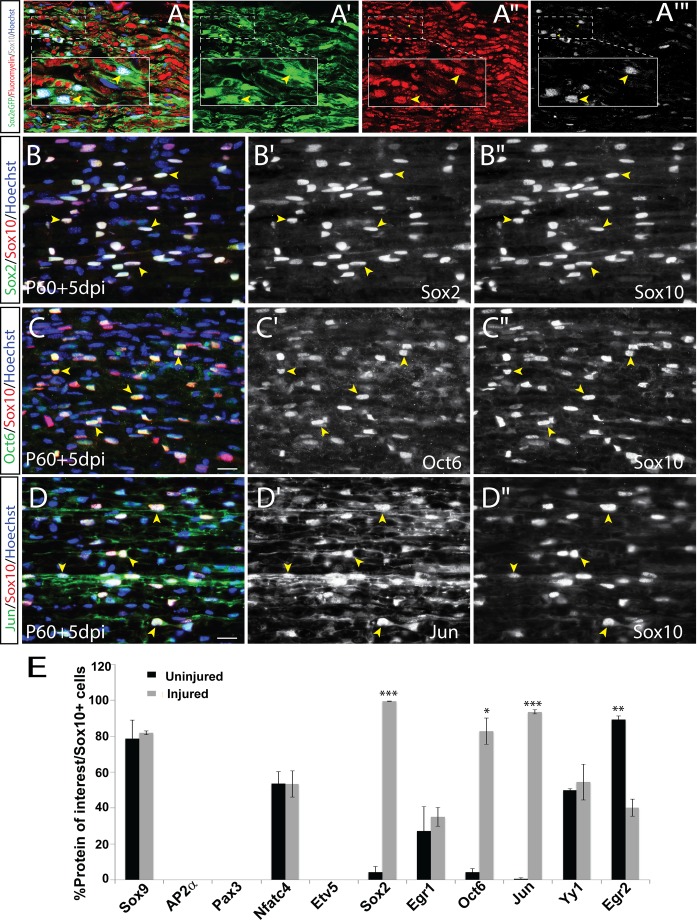
Developmental glial-lineage genes are up-regulated after acute nerve injury.(A-F) Co-labeling of Sox10 (grey) with fluoromyelin (red) and GFP (green) in the distal stump of Sox2-eGFP mice after 5 dpi (A-A‴). Co-labeling of Sox10 with Sox2 (B-B''), Oct6 (C-C''), and Jun (D-D''). Merged images of protein of interest (green), Sox10 (red) and Hoechst (blue) (A-E). Yellow arrowheads indicate co-labelled cells. Quantification of percentage of Sox10+ cells that co-express each of the proteins of interest (F). Error bars = S.E.M. Scale bars, 20μm.